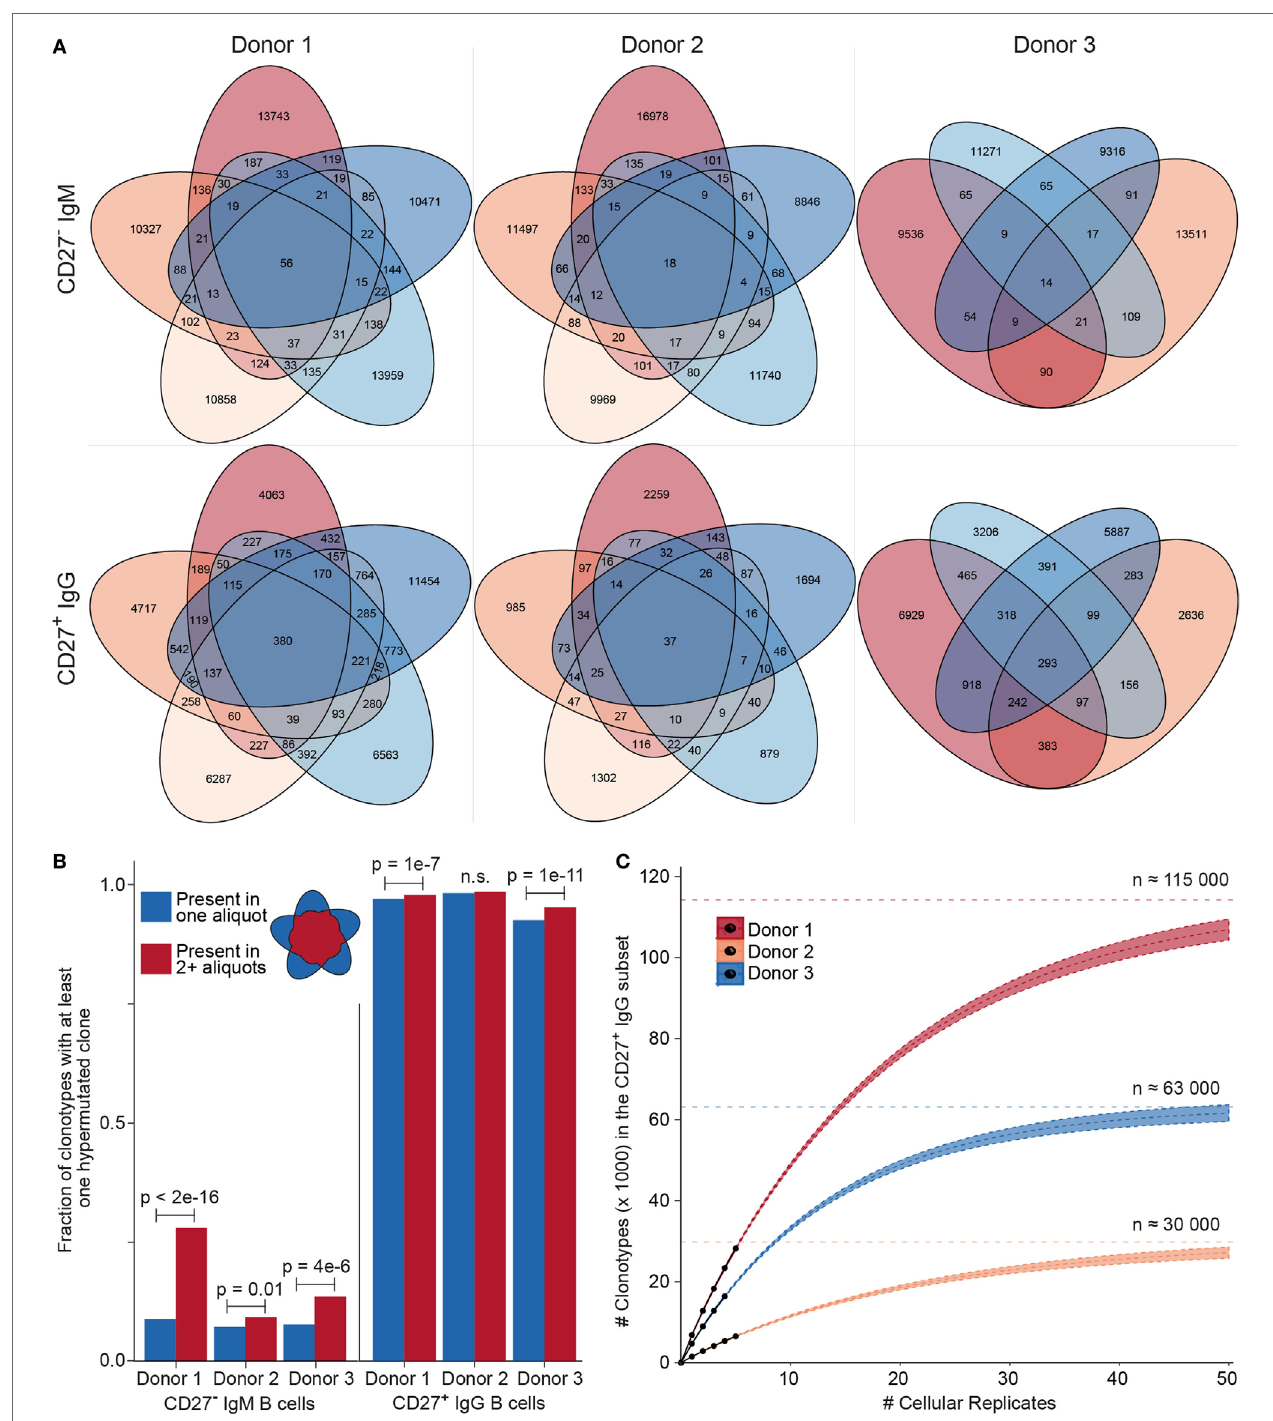
FIgURe 6 | Clonotype diversity analysis across cellular replicates of naïve (CD27 − IgM + ) and memory (CD27 + IgG + ) B cells. (A) Venn diagrams show the presence of clonotypes [80% complementarity determining region 3 (CDR3) a.a. similarity to least one clone in the cluster, same CDR3 a.a. length, same IGHV, and IGHJ gene segment usage] across cellular replicates (2 × 10 5 cells each) from each donor B cell subset. (B) Bar graph showing the fraction of clonotypes containing at least one variant with at least one nt somatic hypermutation (SHM). Blue and red bars indicate clonotypes identified either in only one aliquot (unique) or in several aliquots (shared), respectively. The p -values represent significance using Fisher’s exact test. (c) Species accumulation curves for CD27 + IgG + B cells: the number of newly discovered clonotypes from each additional cellular replicate (black circles) is plotted. Extrapolating the observed overlap provides an estimate for the total number of distinct clonotypes (Chao2 estimator: D1 = 113,794 ± 1,701; D2 = 29,609 ± 958; D3 = 63,172 ± 1,176) and the approximate amount of cellular replicates needed to discover all clonotypes present in the peripheral blood CD27 + IgG + population.